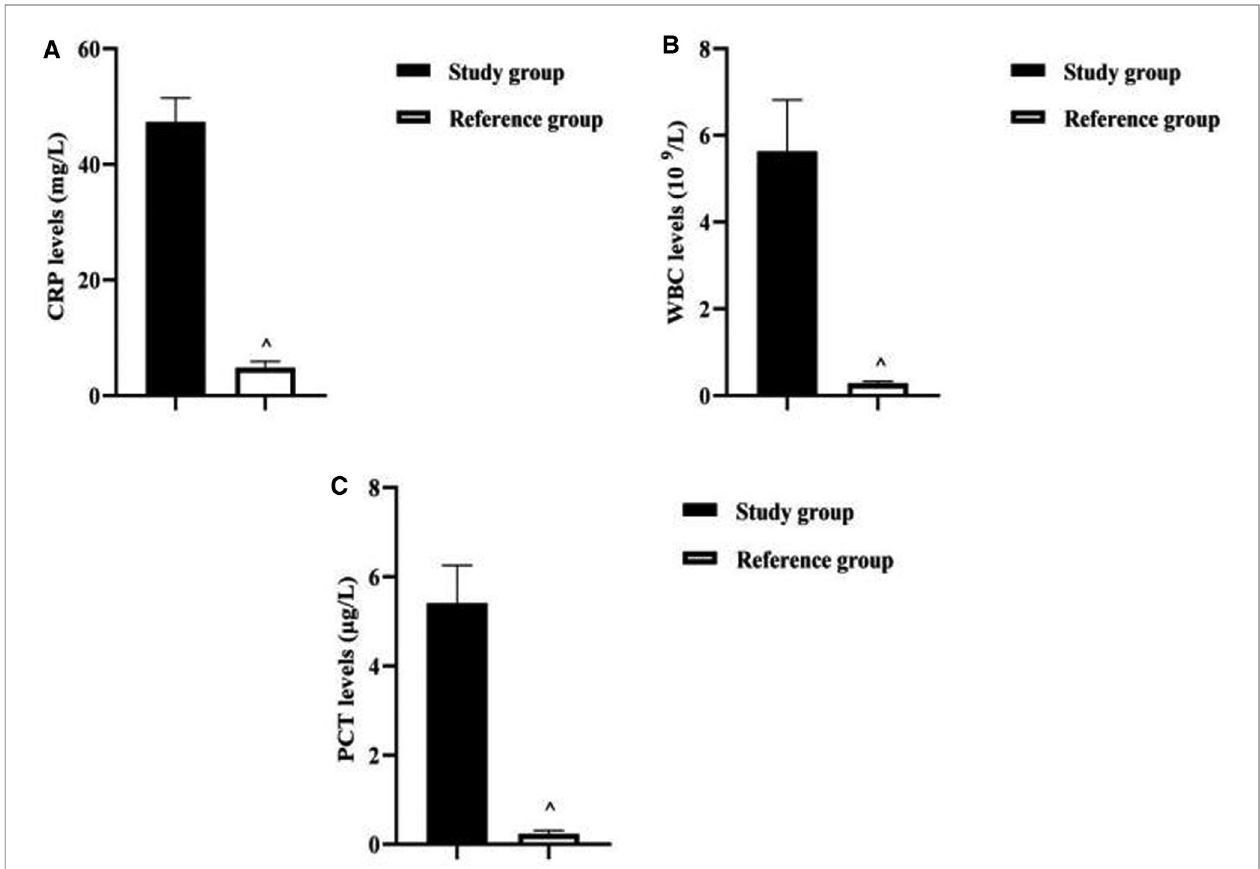
FIGURE 3 | Analysis of serological characteristics of two groups of newborns. Note: ( A ) Comparison of CRP levels between two groups of neonates. ( B ) Comparison of WBC levels between two groups of neonates. ( C ) Comparison of PCT levels between two groups of neonates. Comparison with the study group ^ P